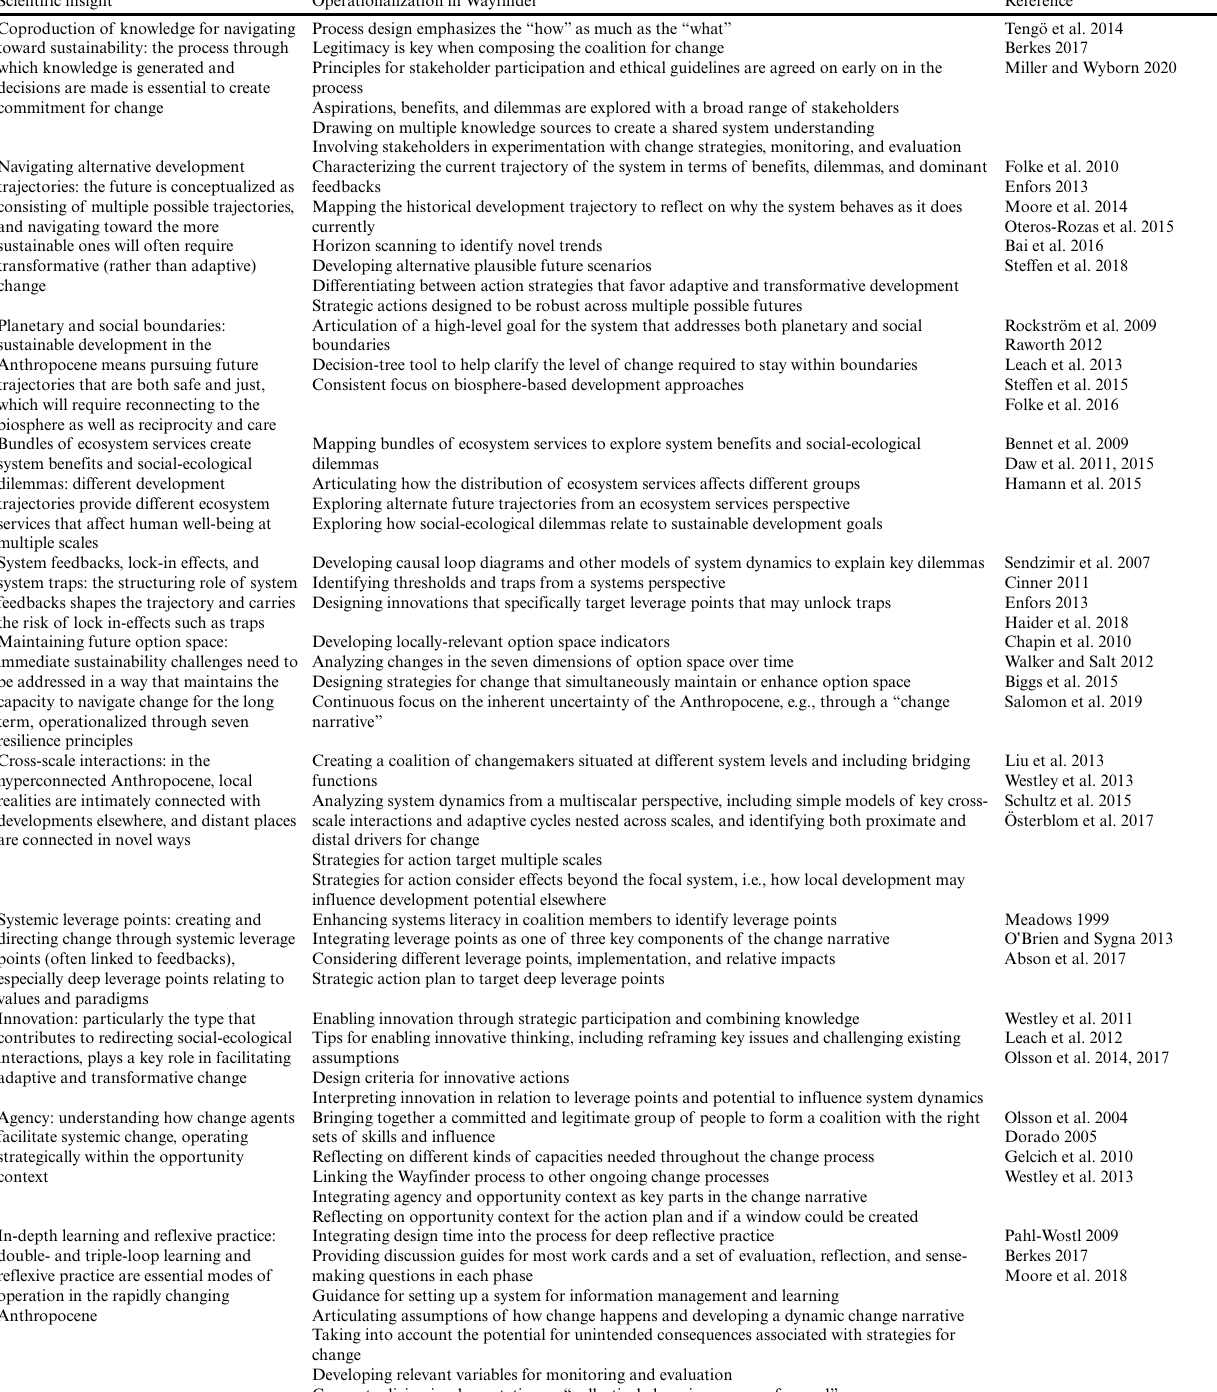
Table 2. Recent insights in resilience science and how Wayfinder builds on and operationalizes them, with key